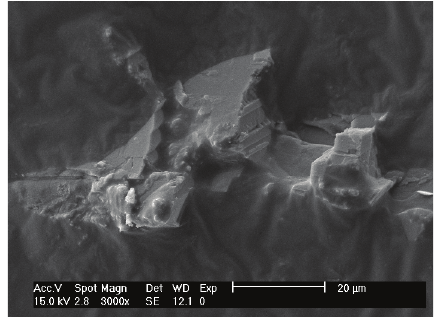
Figure 6: Interface between RAP and asphalt emulsion.